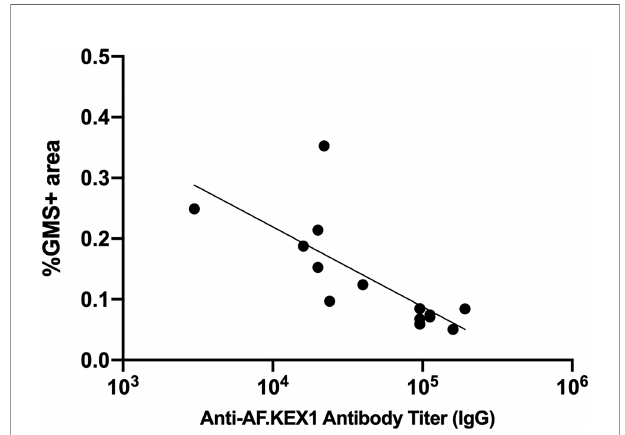
FIGURE 6 | Correlation of anti-AF.KEX1 antibody titers with lung fungal burden. There was a signi fi cant negative correlation between peak antibody titer and fungal burden, by Spearman correlation (r=-0.8284, p